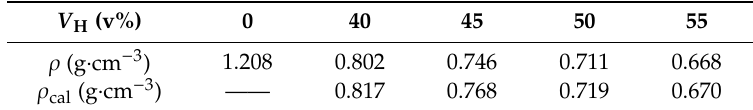
Table 4. The theoretical and tested density of the composite at V H = 0, 40, 45, 50, and 55 v%.